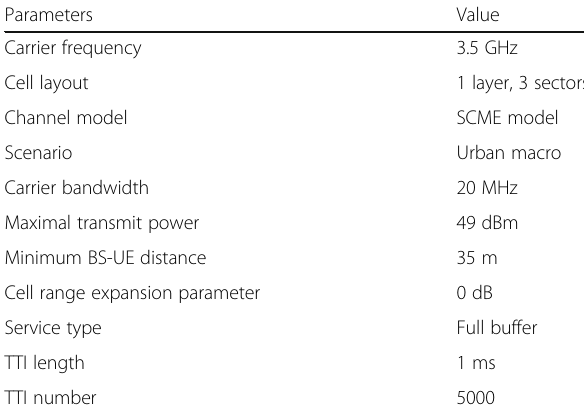
Table 1 Simulation